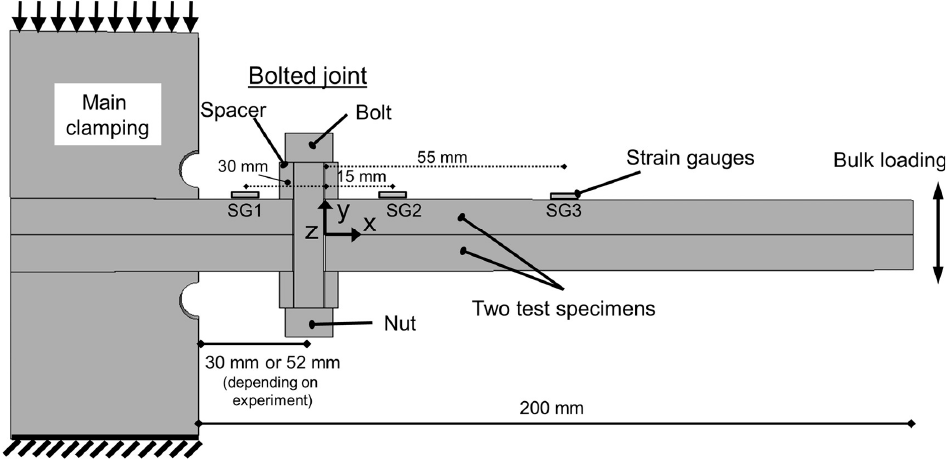
Figure 18. The experimental apparatus used for measuring fretting fatigue in bolted joints [119].